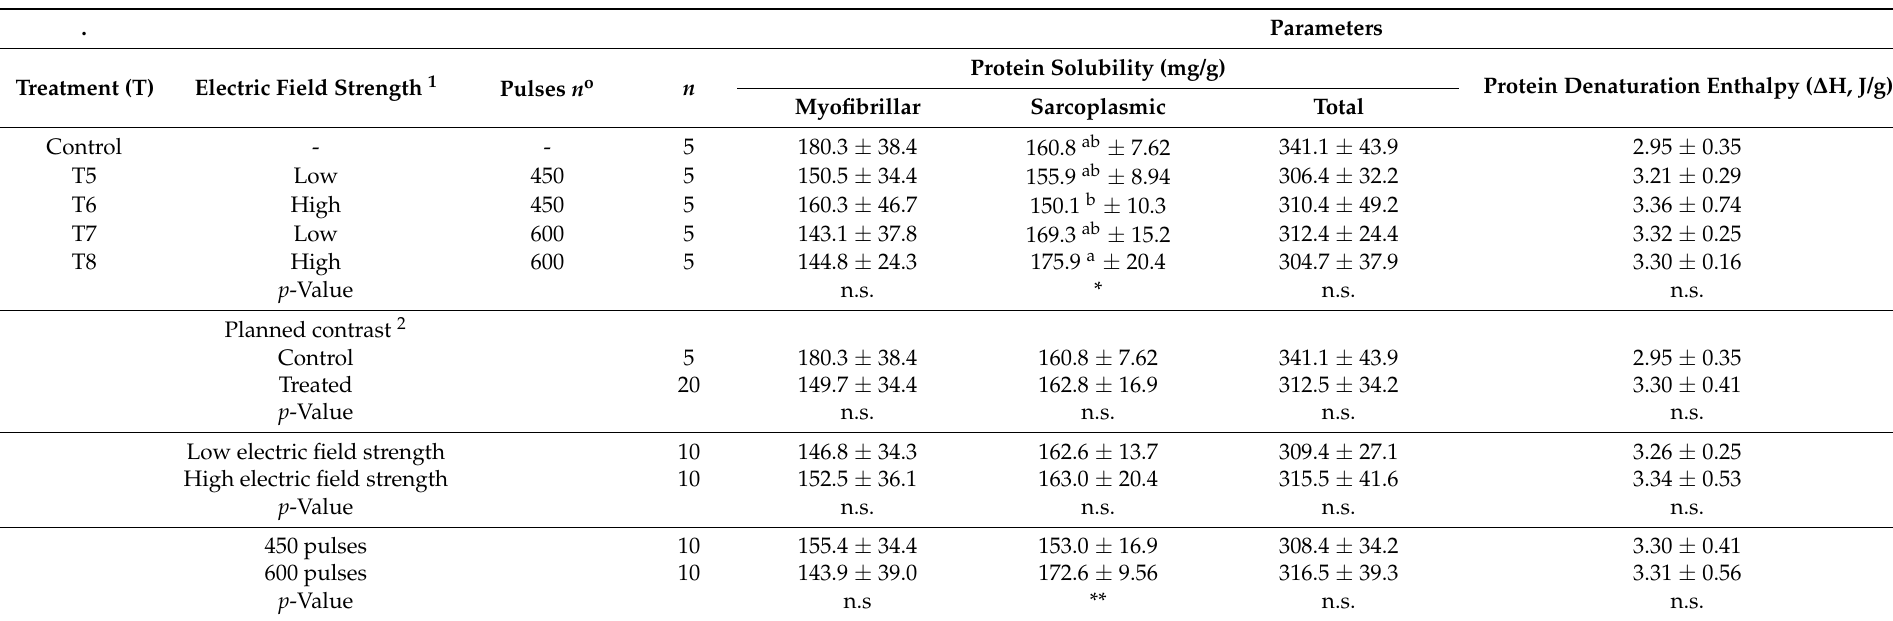
Table 6. Average protein solubility (mg/g) and total protein denaturation enthalpy ( ∆ H, J/g) of chicken meat samples subjected or not to pulsed electric field treatments. Data are expressed as least square means ± standard deviation. a,b = means lacking a common letter significantly differ ( p < 0.05). * = p < 0.05; ** = p < 0.01; n.s. = not significant.